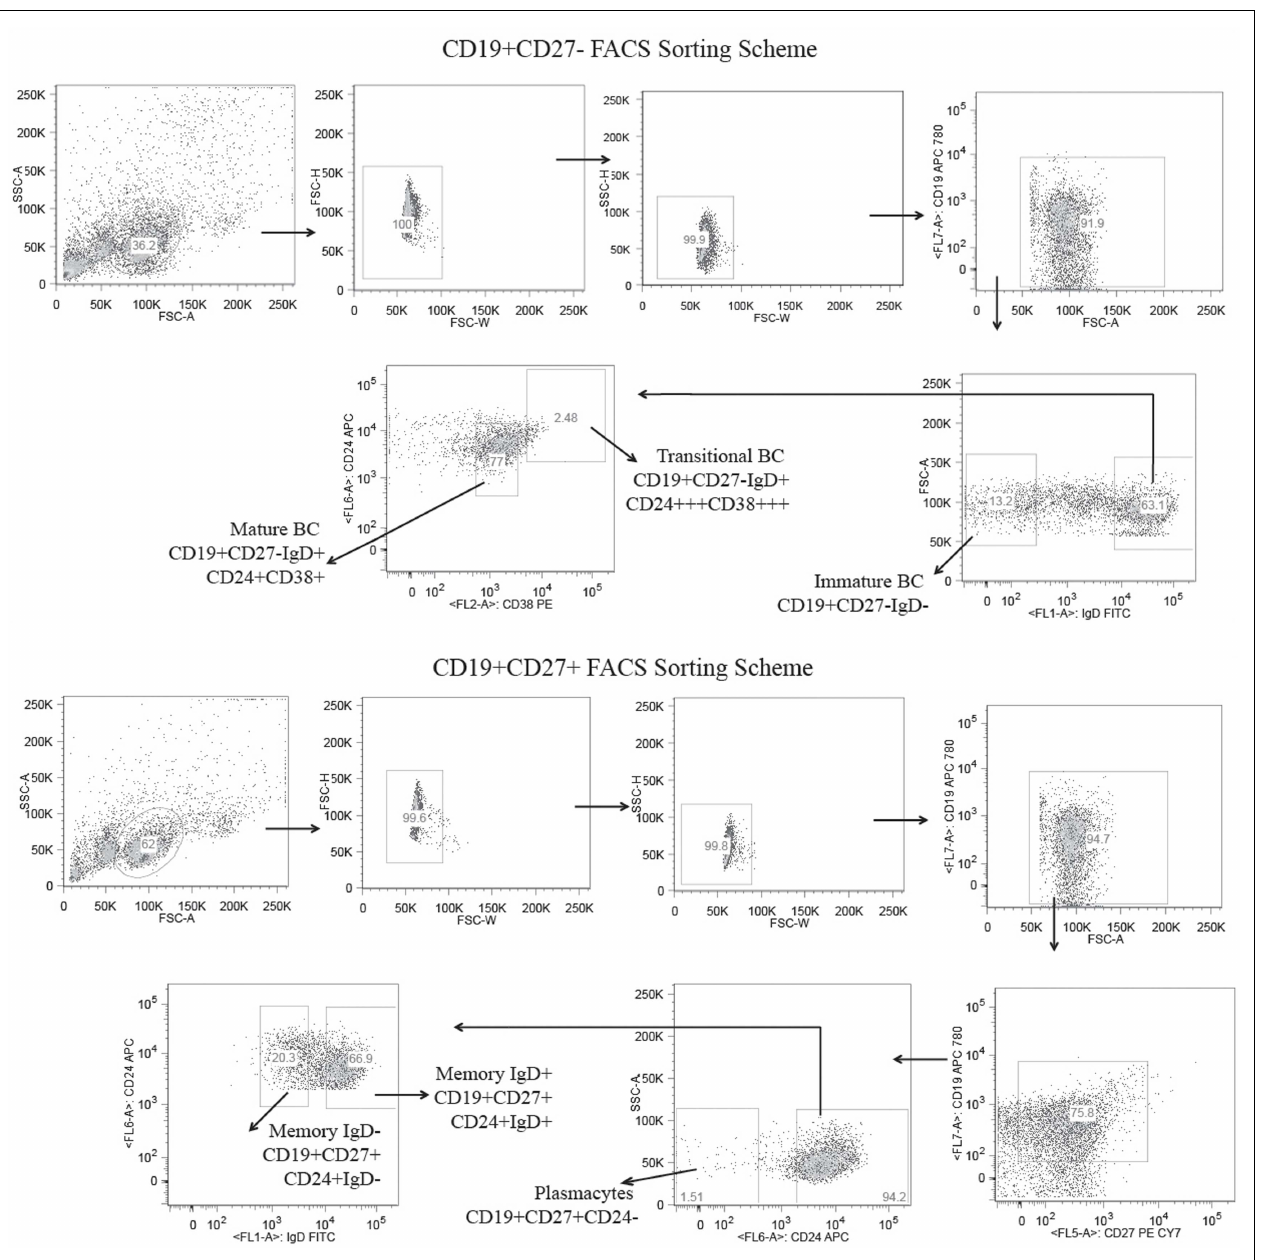
(CD19 + /CD27 + /IgD + /CD24 + ), IgD − memory B cells (CD19 + /CD27 + /IgD − / CD24 + ), and plasmacytes (CD19 + /CD27 + /CD24 − ) using the high speed sorting cytometer.The CD19 + /CD27 − B cells were stained with CD19, APC 780, CD24 APC, CD38 PE, and IgD FITC, and sorted into mature (CD19 + / CD27 − /IgD + /CD38 + /CD24 + ), transitional (CD19 + /CD27 − /IgD + /CD38 +++